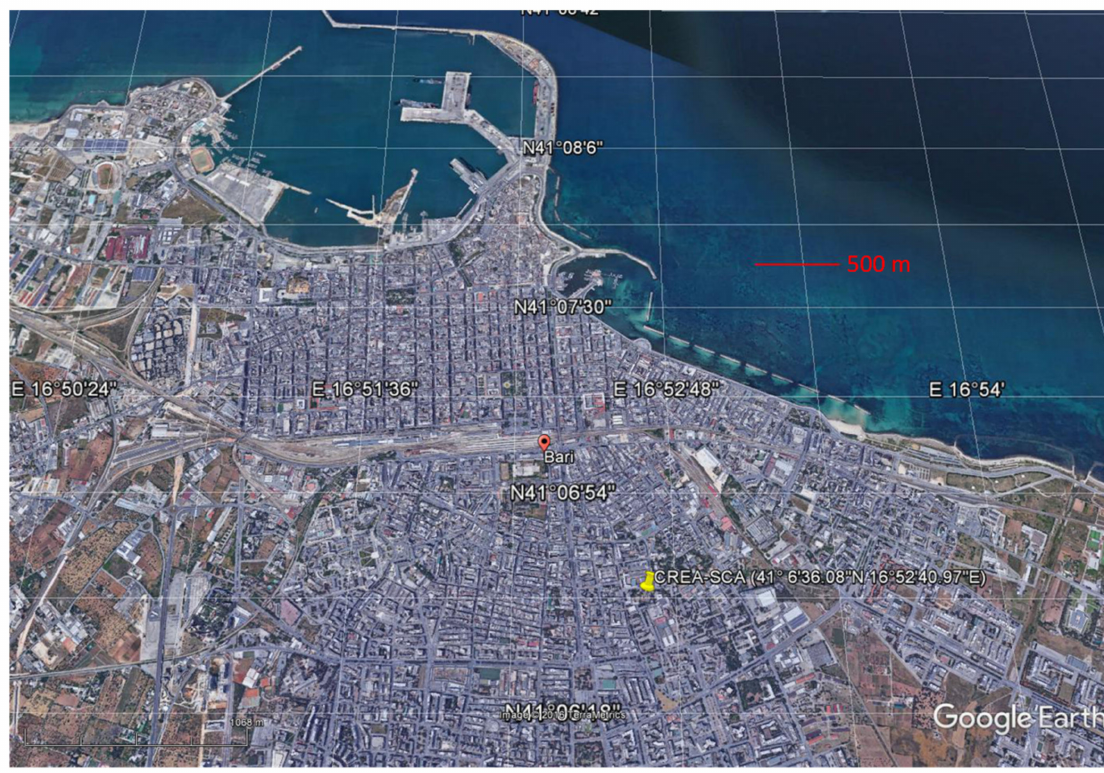
Figure 1. The city of Bari (Apulia, Southern Italy), on the Adriatic Sea. The eddy covariance measurement tower was set up on the rooftop of the CREA-AA building (Agriculture and Environment